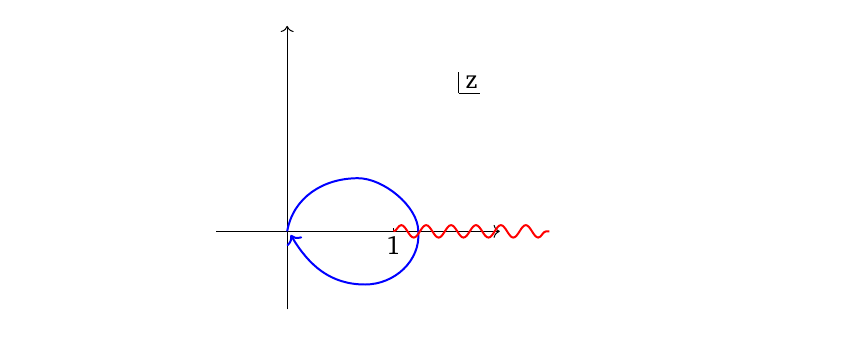
Figure 4: During the analytic continuation for OTOC the cut from 1 to infinity is